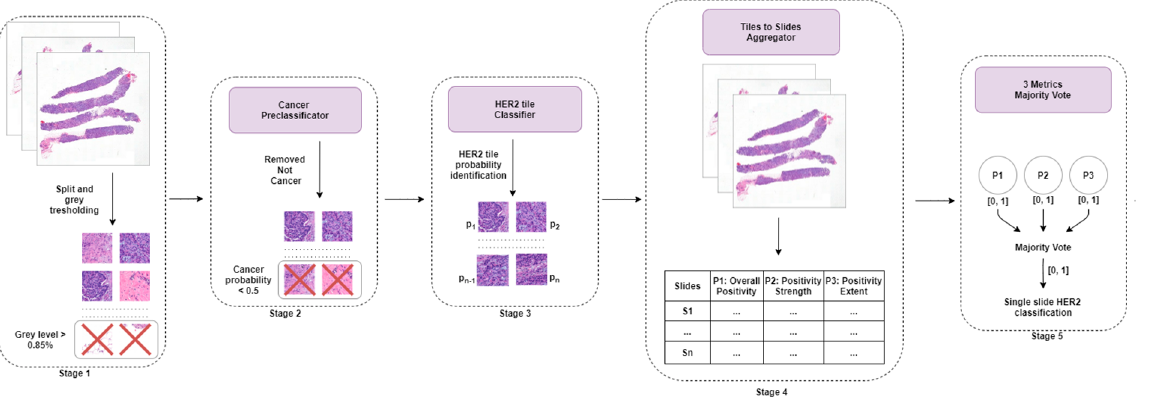
Figure 3. Overall architecture of the model developed by team MITEL.